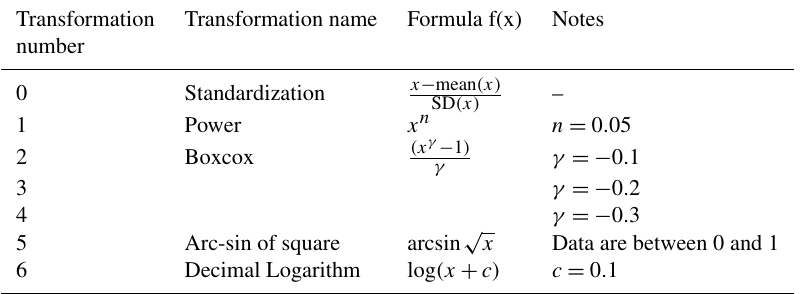
Table 3. Transformations used to normalize the variables listed in Table